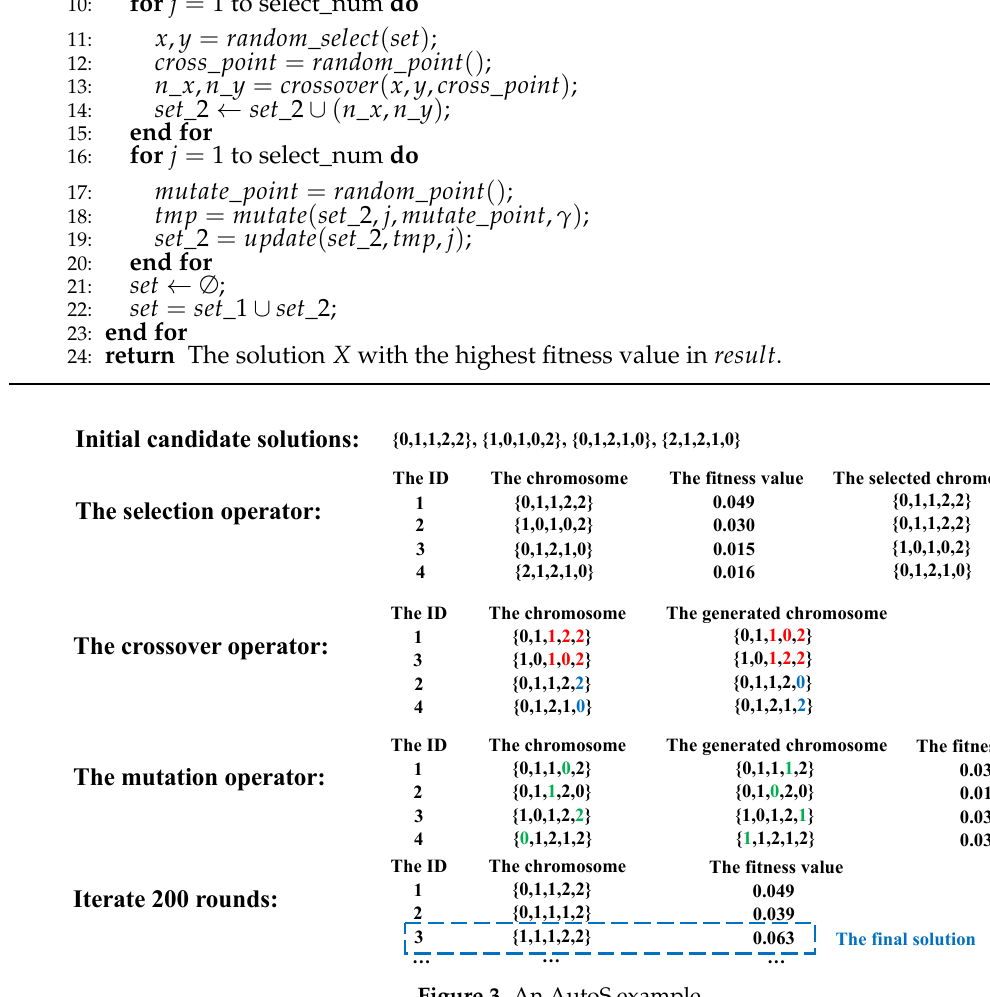
Figure 3. An AutoS